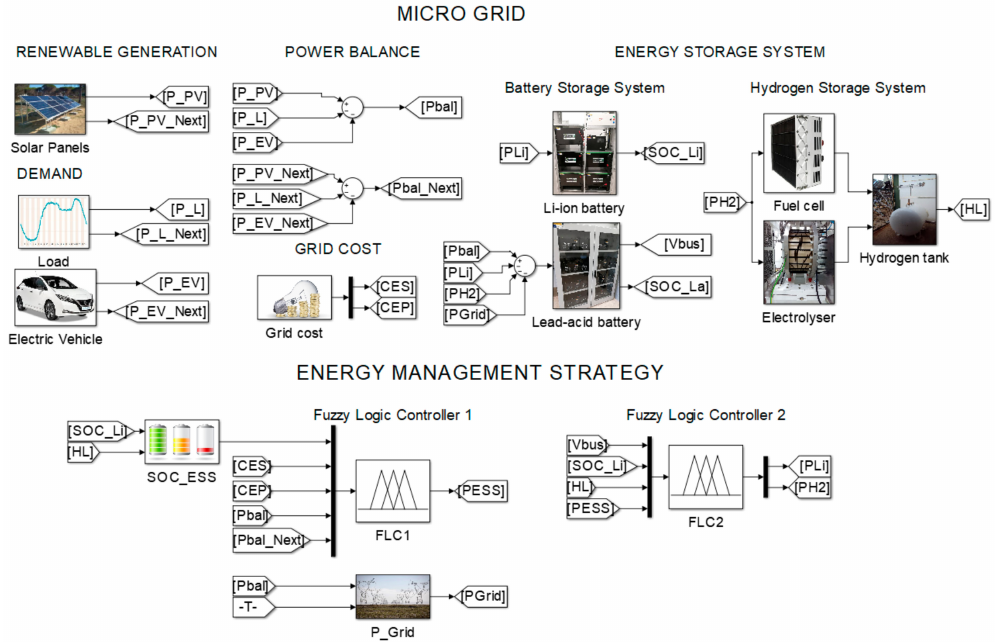
Figure3. MATLAB ® -Simulink ®